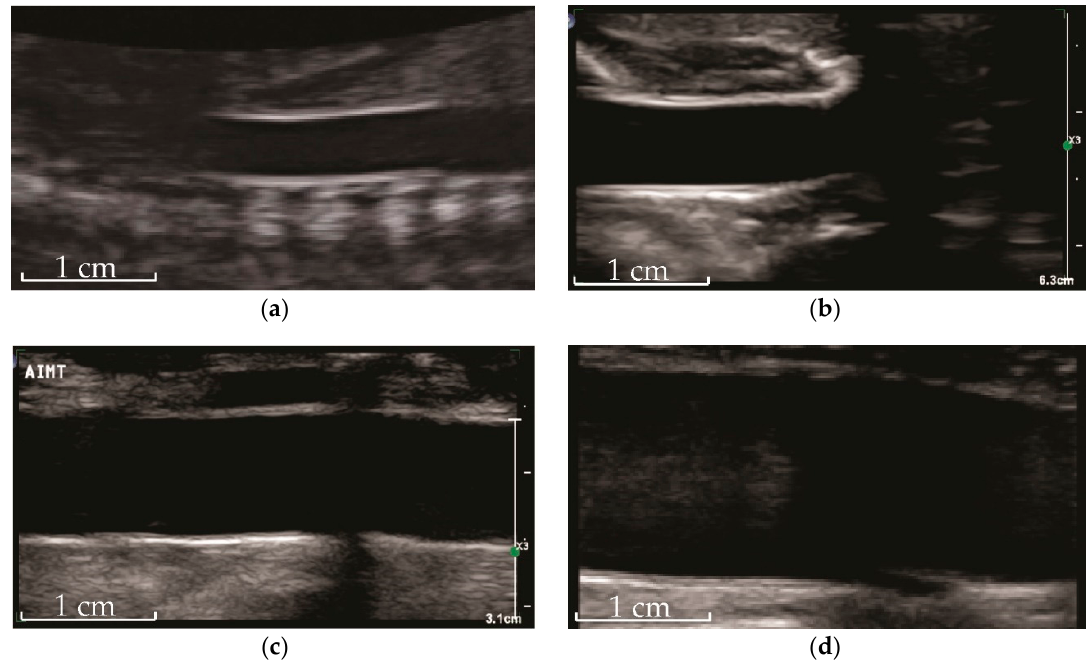
Figure 2. Ultrasound of abdominal aorta showing intima-media complex in a ( a ) fetus, ( b ) newborn, ( c ) child (8 years), and ( d ) young adult (20 years). Indicative scale as indicated.